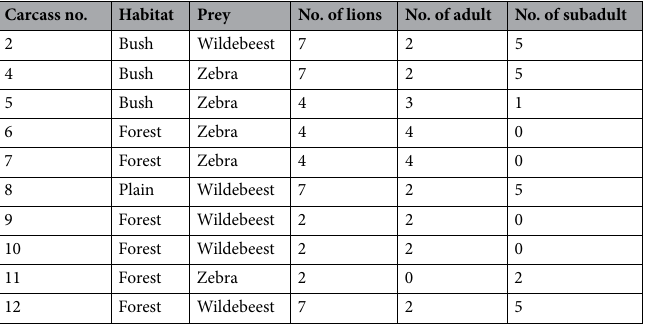
Table 1. Zebra and wildebeest carcasses analyzed in the present study, including the number and type of lion